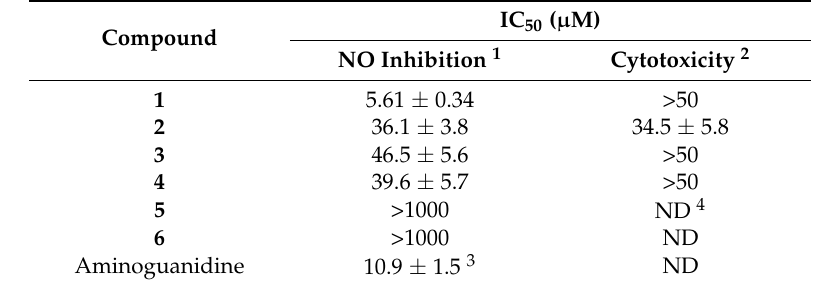
Table 1. Inhibitory activities against NO production and cytotoxicities of 1 β -hydroxy alantolactone ( 1 ) and its derivatives in lipopolysaccharide (LPS)-induced RAW 264.7 macrophages.